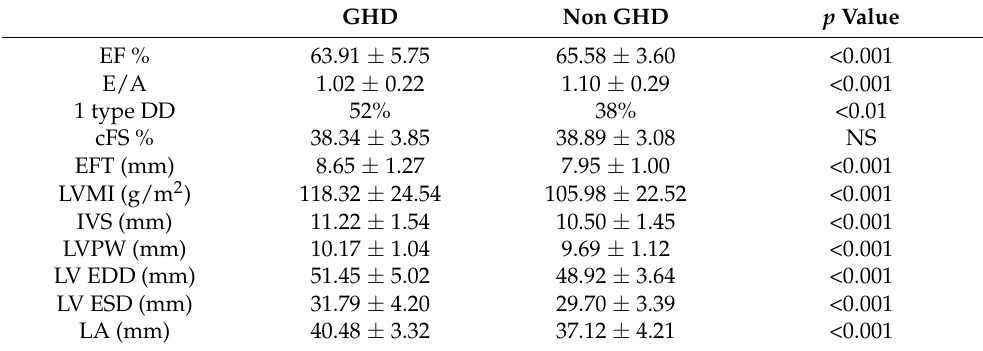
Table 6. Comparison of echocardiographic parameters between the GHD population and the control group.